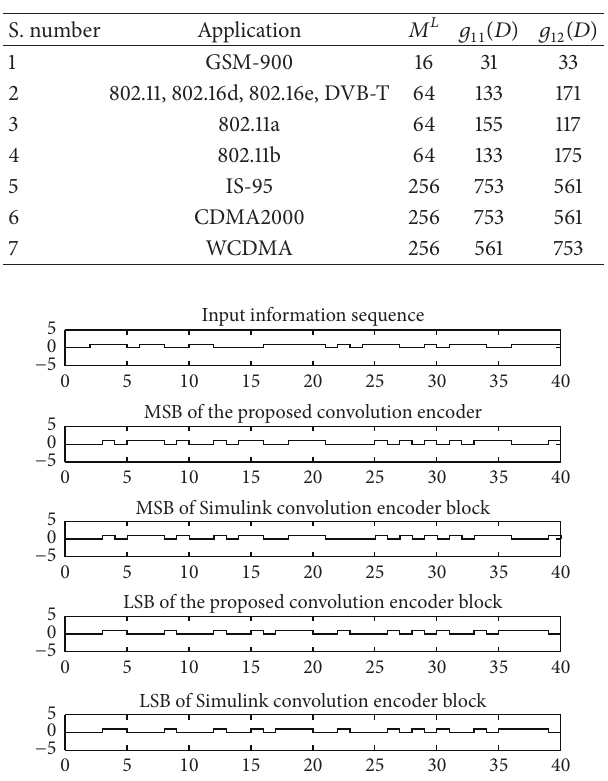
Table 7: The proposed algorithm is tested for the following wireless standards.